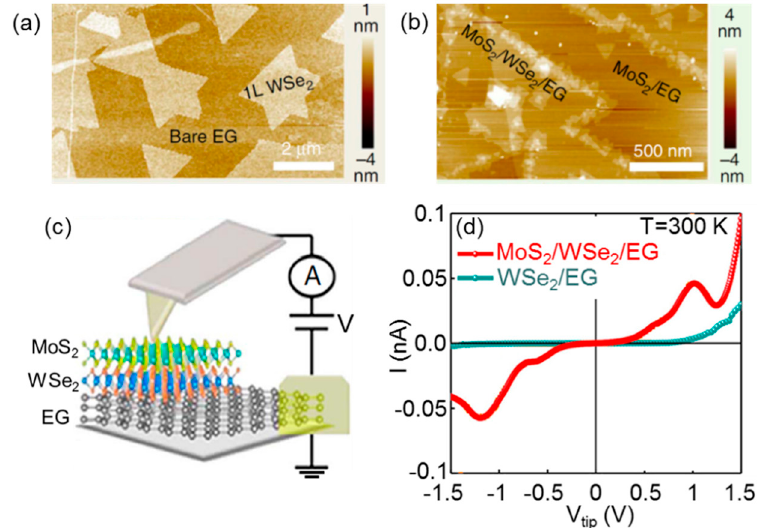
Figure 10. AFM morphology of ( a ) single layer WSe 2 and ( b ) MoS 2 / WSe 2 stacks deposited onto epitaxial graphene (EG) on SiC. ( c ) Schematic of the C-AFM setup for the I-V measurement in this layered system. ( d ) I-V curves recorded at room temperature (T = 300 K) on the WSe 2 / EG p-n junction and on the MoS 2 /WSe 2 /EG heterostructure. Images adapted with permission from Reference [ Error! Bookmark not defined. ], copyright from the Nature Publishing Group 2015.